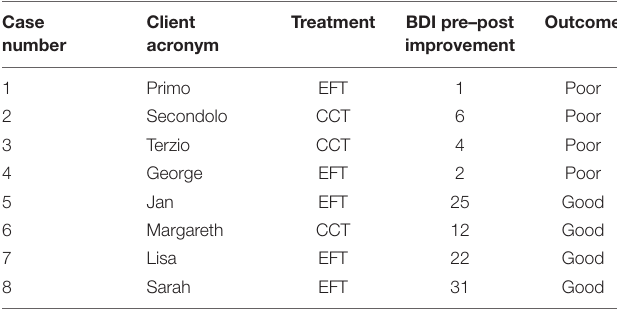
TABLE 1 | Descriptive statistics of the